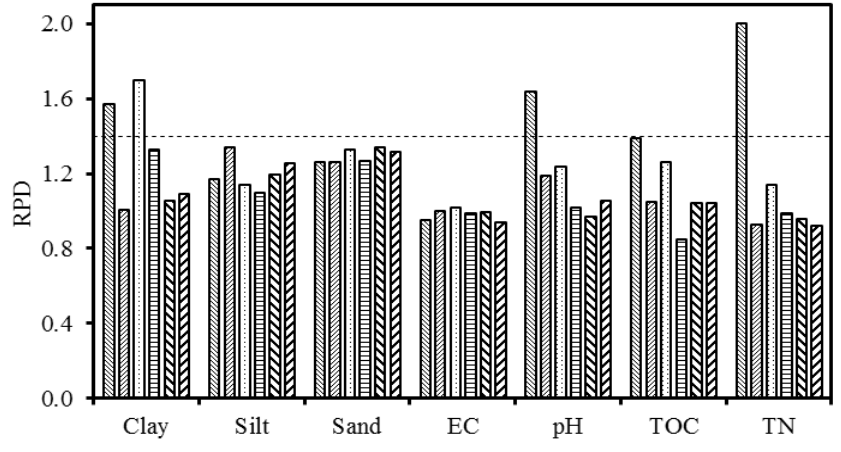
Figure 5. RPD statistic of individual and combined fields in 0–15 cm and 15–30 cm depths for the EWs method. Legend: = conventional field 0–15 cm depth, = conventional field 15–30 cm depth, = organic field 0–15 cm depth, = organic field 15–30 cm depth, = combined fields 0–15 cm depth and = combined fields 15–30 cm depth. Dashed line indicates the RPD value of 1.4, which is a threshold commonly used in